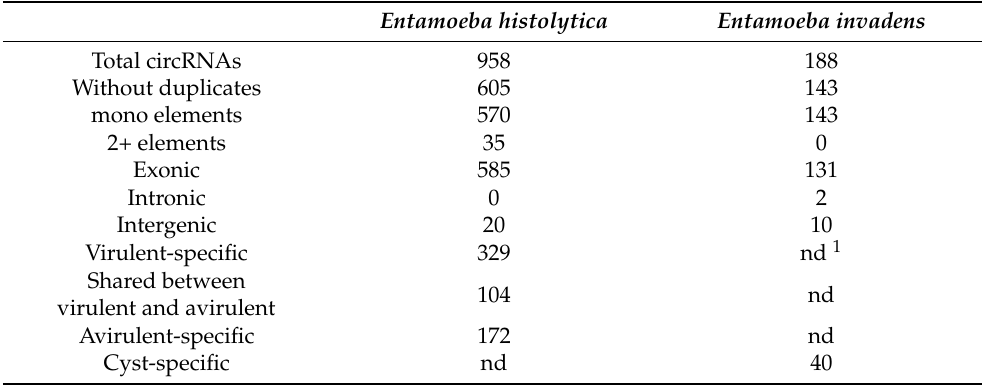
Table 1. Summary of Entamoeba histolytica and Entamoeba invadens